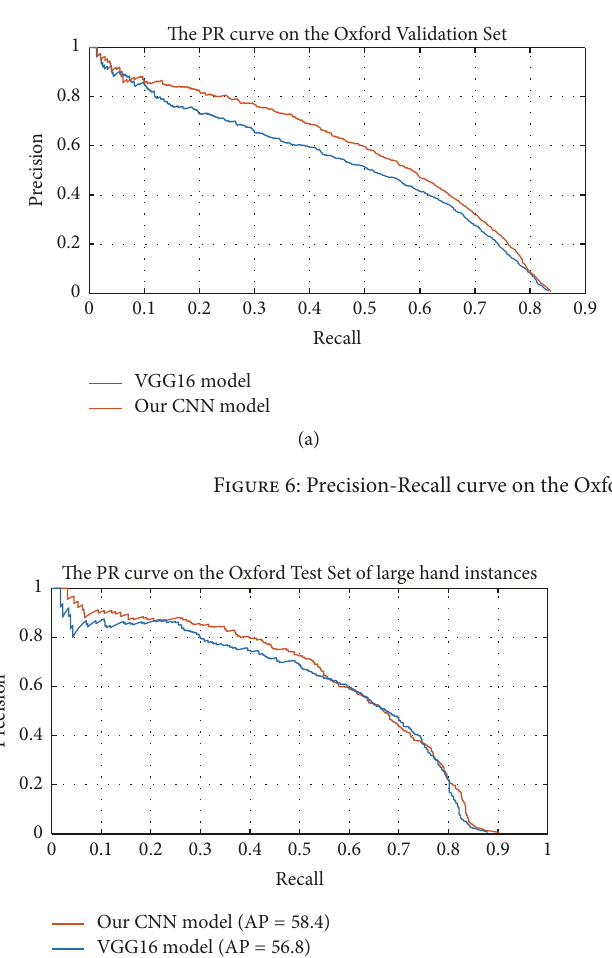
Figure 7: Precision-Recall curve on the Oxford test dataset with only large hand instances considered.